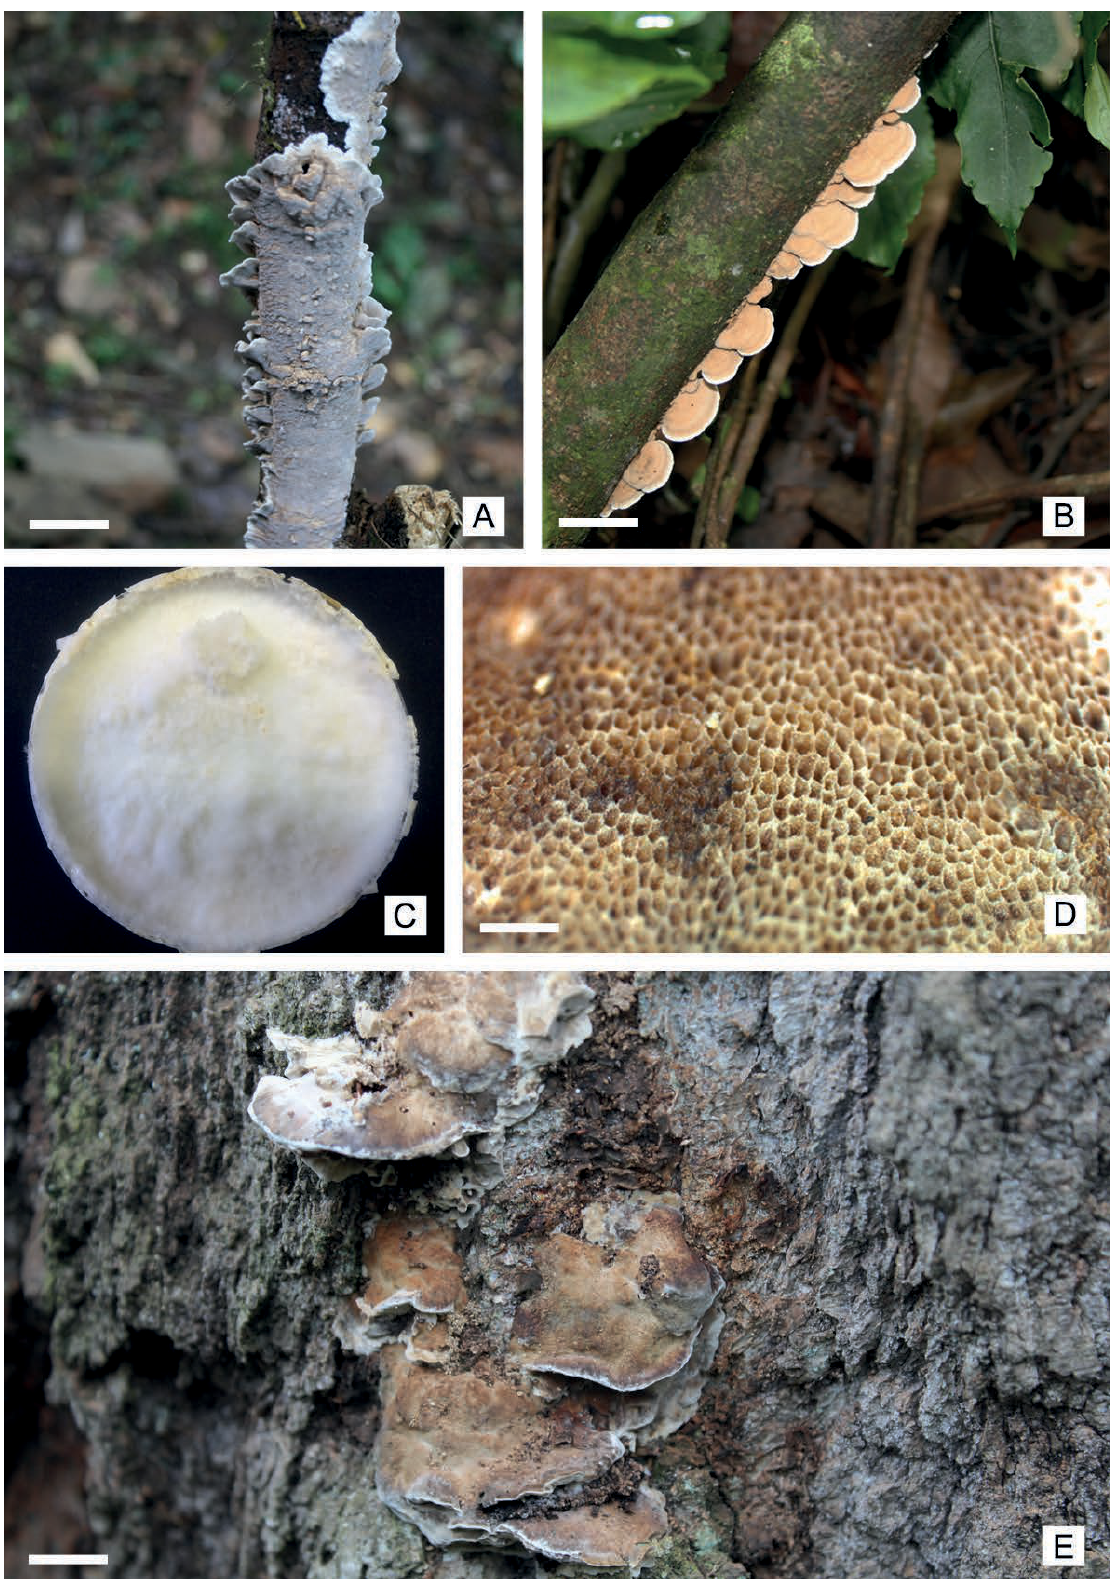
Figure 4 – Macroscopic features of Bjerkandera species. A – D . Bjerkandera mikrofumosa (SP466878). A . Hymenophoral surface. B . Pilear surface. C . Mycelial growth after six weeks in MEA (MV435, CCIBt). D . Poroid surface detail. E . Basidiomata of Bjerkandera fumosa (SP498907). Photographs by V. Motato-Vásquez. Scale bars: A, B, E = 1 cm; D = 0.5